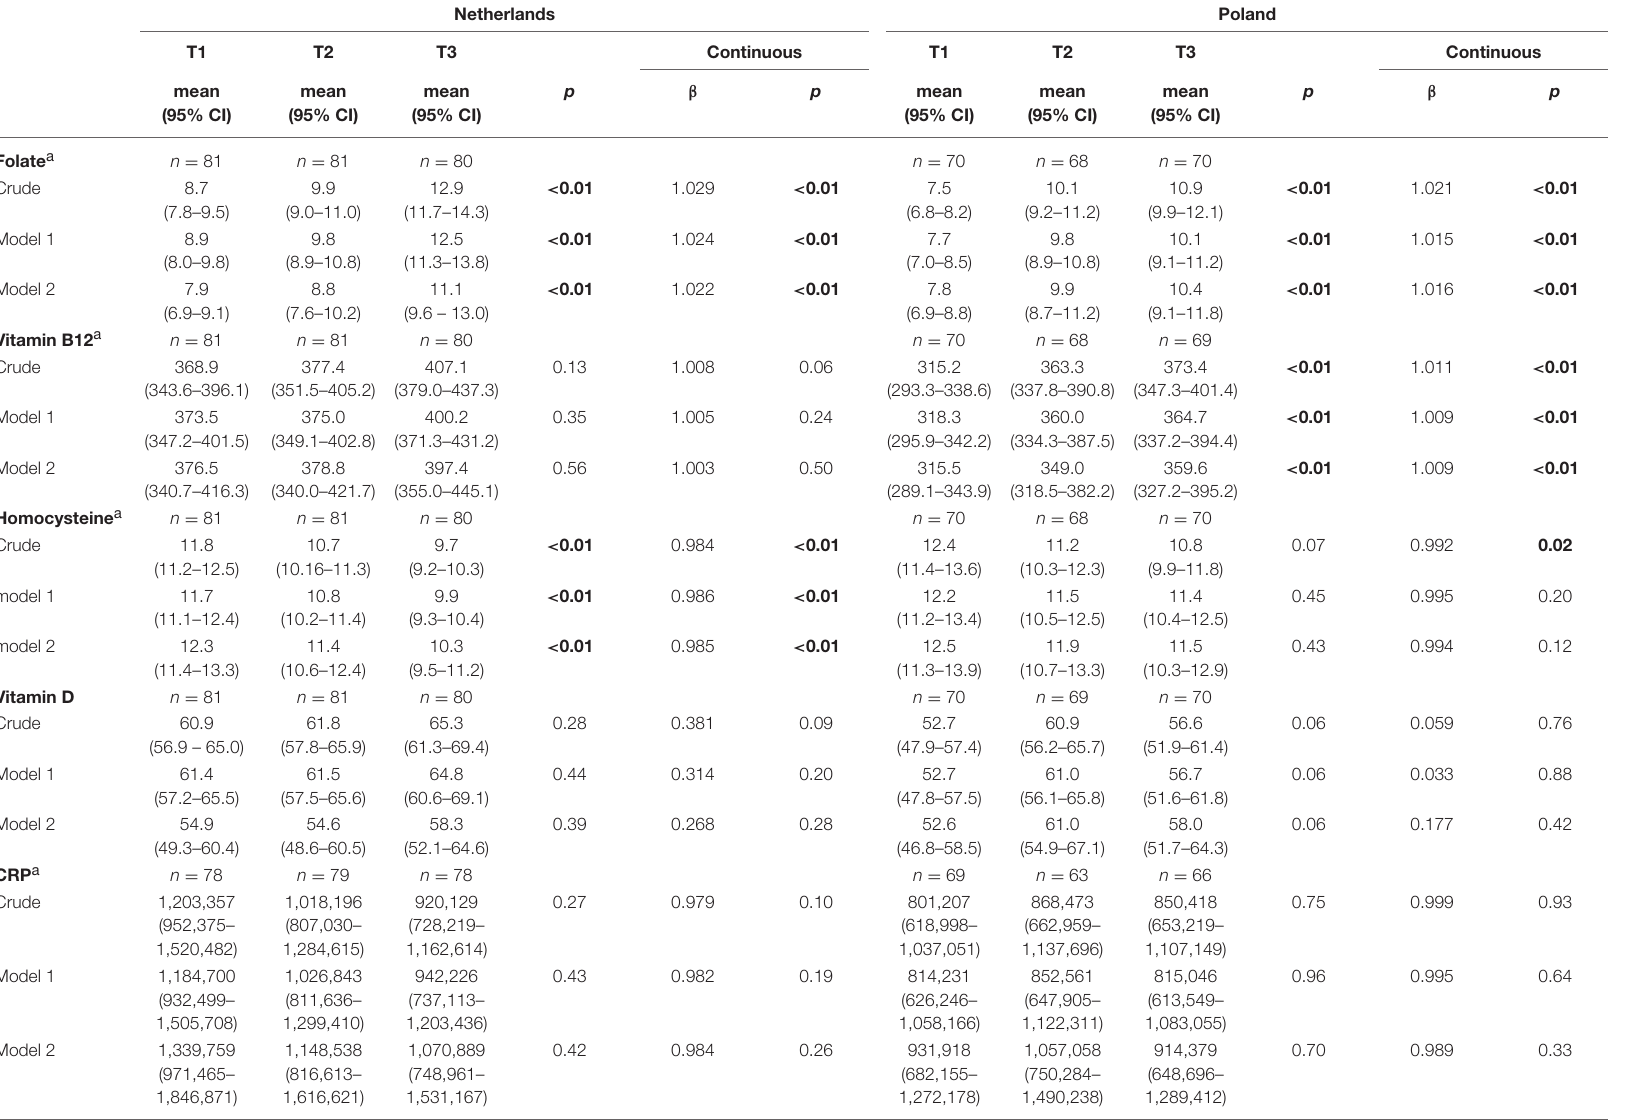
TABLE 4 | Association between the Elderly Nutrient-Rich Food (E-NRF7.3) score and markers of nutritional status and inflammation in Dutch and Polish NU-AGE